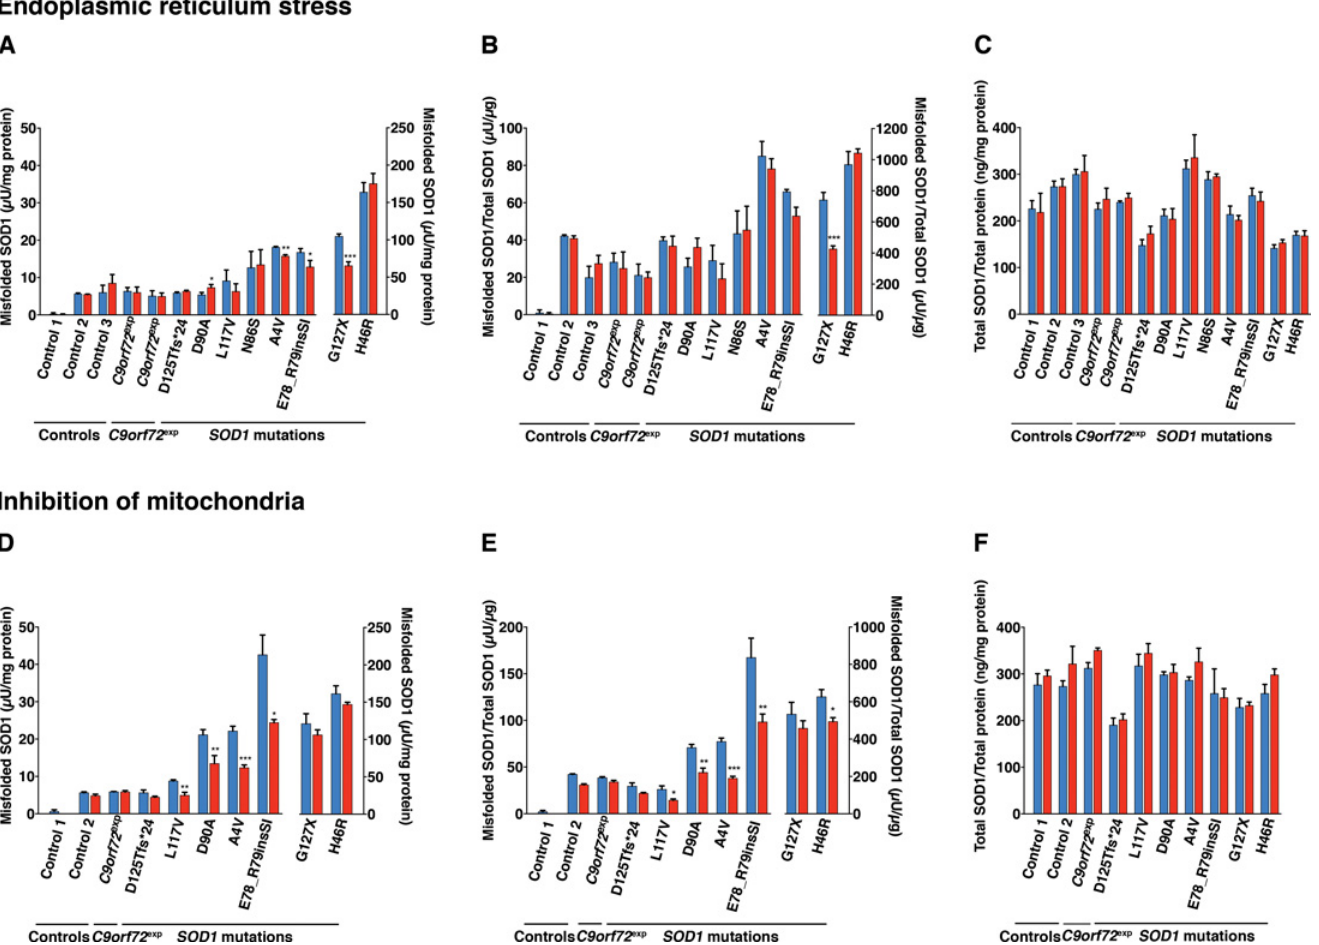
Fig 3. Effect of induction of ER stress and perturbation of mitochondria on the levels of misfolded and total SOD1 in fibroblast lines. Misfolded and total SOD1 in lysates of fibroblasts were analysed with the 24 – 39 misELISA and ELISA for total SOD1, respectively. Fibroblast cell lines were cultured in triplicate for 24 h in the absence (blue) and presence (red) of the ER-stress inducer tunicamycin (A-C; 0.5 μ g/ml) and the mitochondrial inhibitor rotenone (D-F; 5 μ M). Data is expressed as the mean ± SD (n = 3), * p < 0.05, ** p < 0.01, *** p < 0.001 compared to respective non-treated control (Welch test and two- tailed unpaired